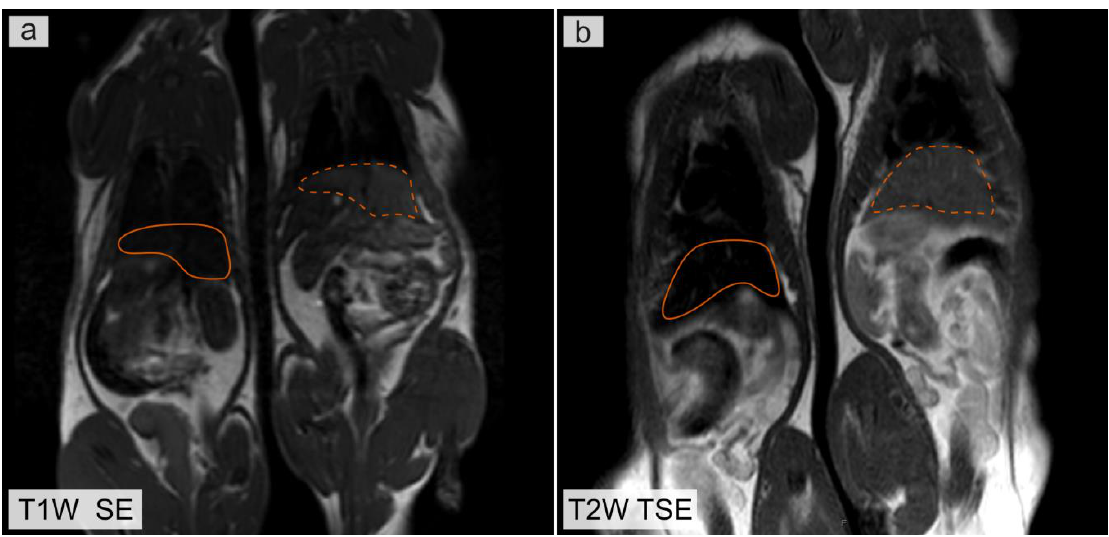
Figure 3. Magnetic resonance (MR) images of rats obtained 24 h after injection of a microcapsule suspension. ( a ) T1 weighted MR image. ( b ) T2 weighted image. The rat on the right is a control rat, without injection of microcapsules.